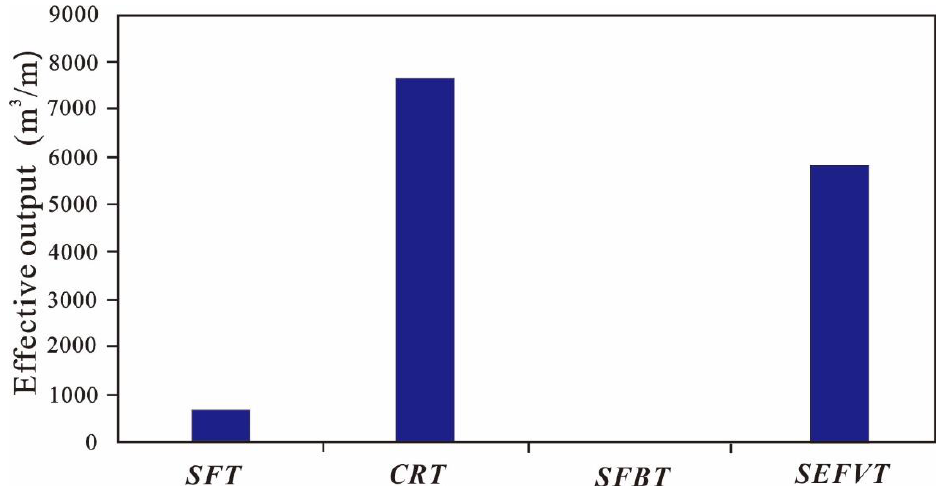
Figure 7. Variation of gas output of four void space types (SFT:solution-filling type; CRT:cement-reducing type; SFBT:solution-filling breccia type; SEFVT:solution-enlarging fractures and vugs type).